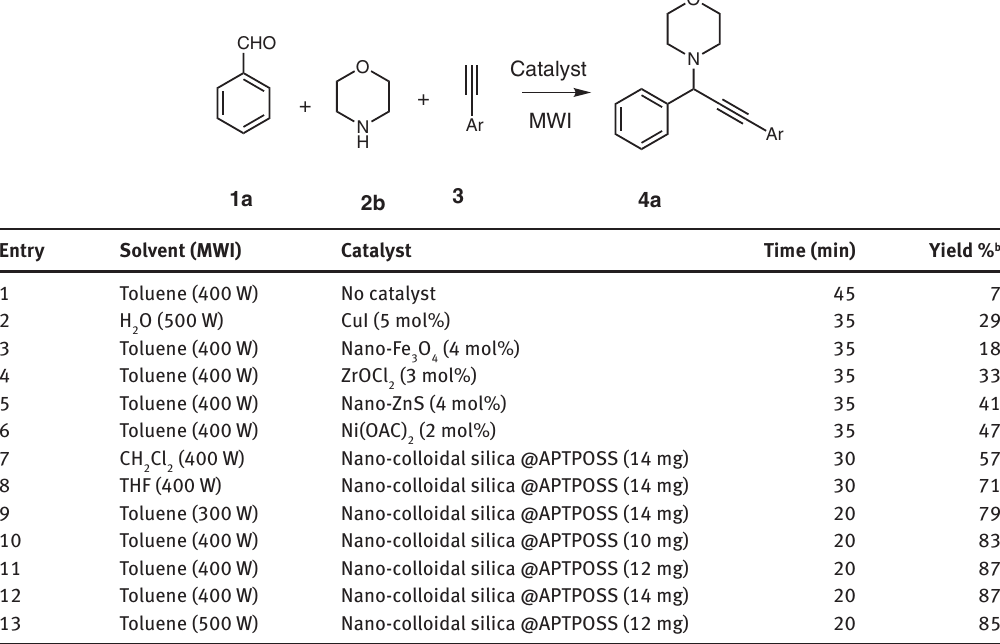
Table 1: Optimization of reaction conditions using different catalysts under microwave irradiation (300–500 W) a .